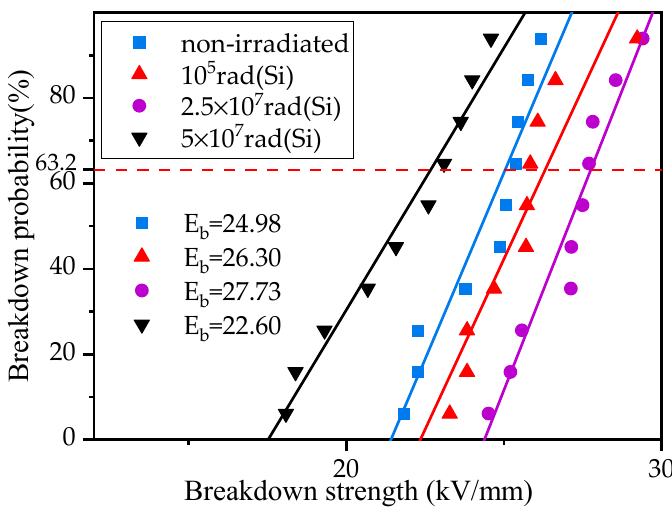
Figure 15. Breakdown